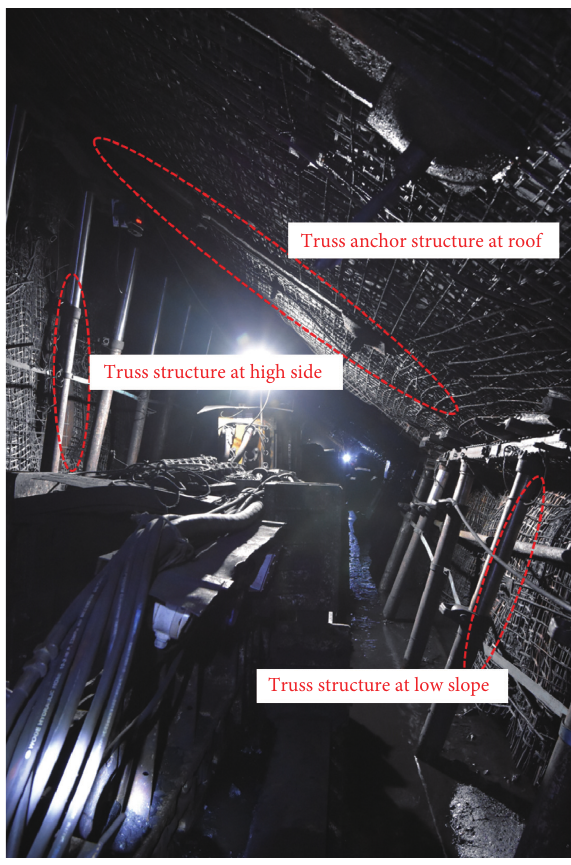
Figure 4: Transportation roadway with new truss support structure.